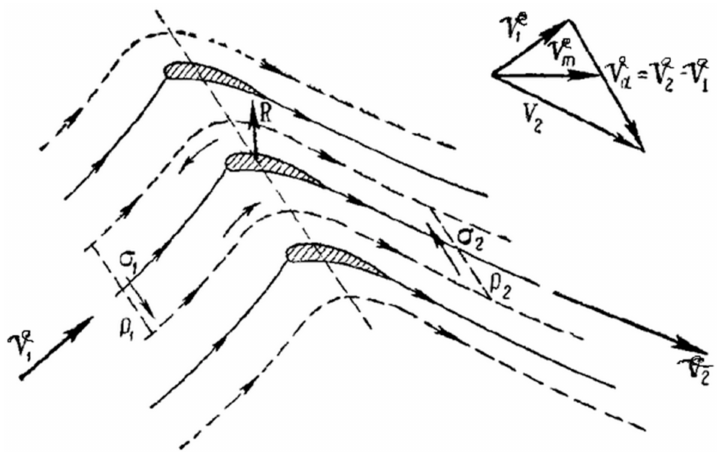
Figure 4. Current tube in the plane of the